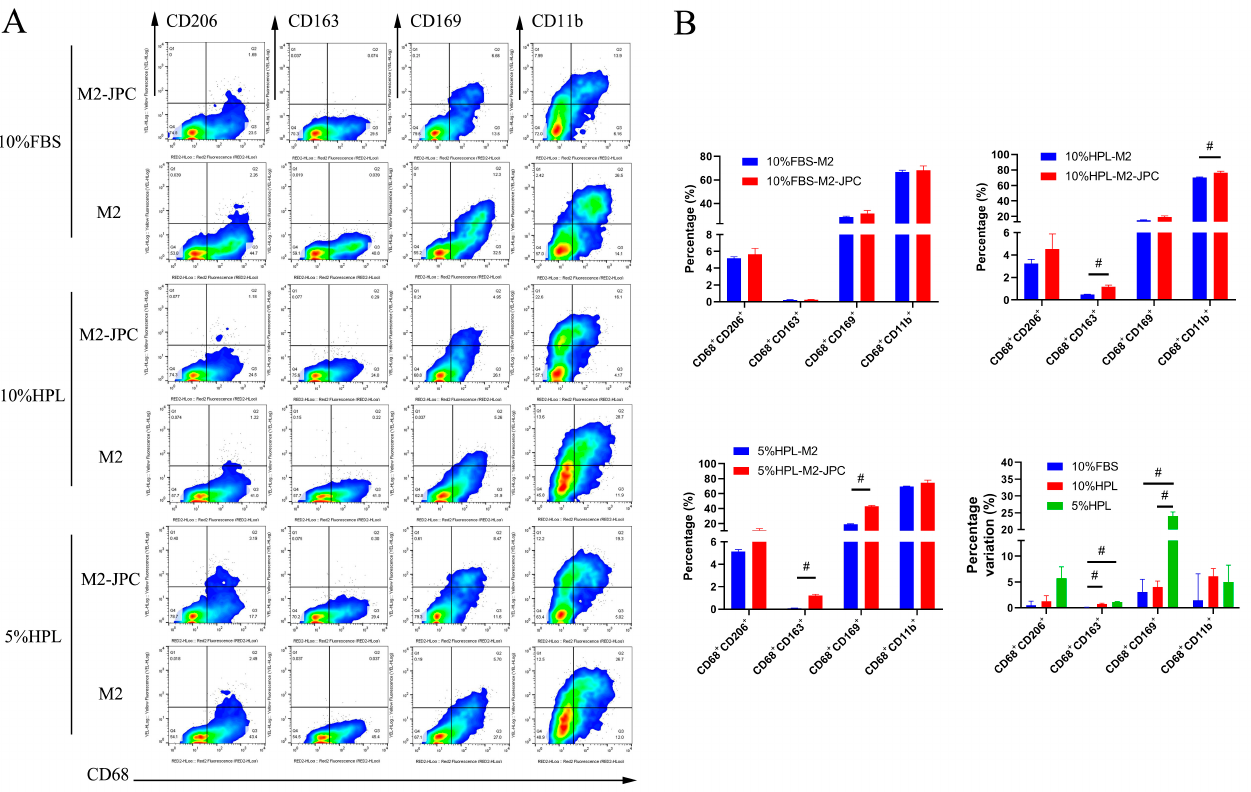
Figure 6. Surface marker expression by M2 macrophages after direct coculture with JPCs under FBS and hPL culture supplementation. ( A ) Representative flow cytometric dot plots for CD206, CD163, CD169, and CD11b protein expressions in macrophages in monocultures (M2) and cocultures (M2-JPC). ( B ) CD206, CD163, CD169, and CD11b protein expressions and percentage variation in monocultures (M2) and cocultures (M2-JPC), depending on the used culture supplementations ( n = 3, # p < 0.05).